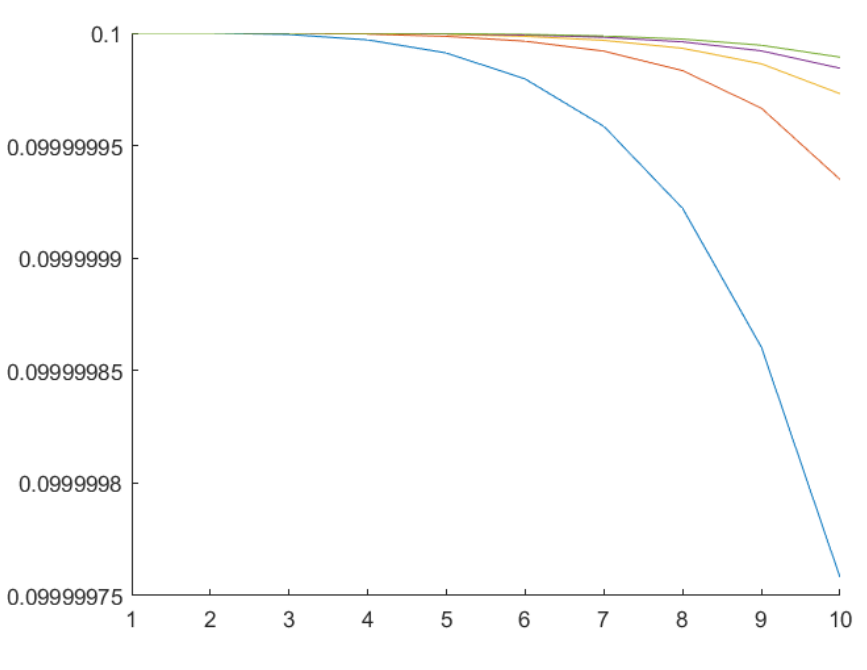
Figure 5. “Feather” angles β change under the non-multiagent control law (21).